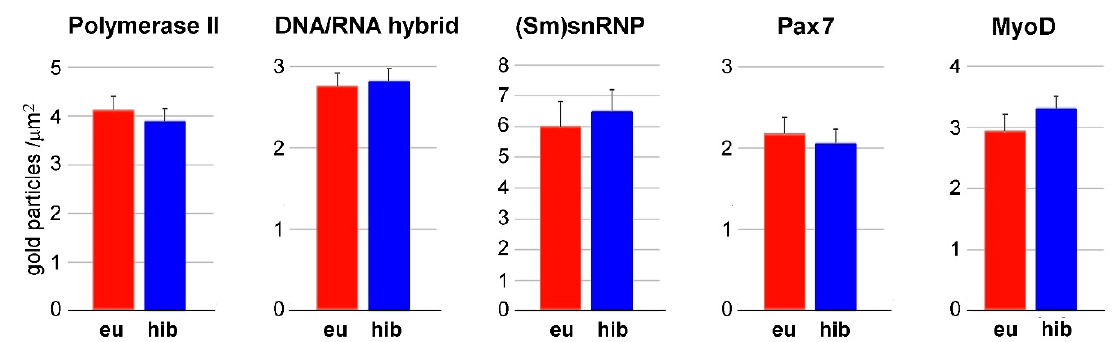
Figure 4. Quantitative immunoelectron microscopy. Labelling density (gold particles / µ m 2 ) of RNA processing factors in the interchromatin space (mean ± SE) of SC nuclei from skeletal muscles of euthermic (eu) and hibernating (hib) dormice. No significant difference was found between euthermia and hibernation.